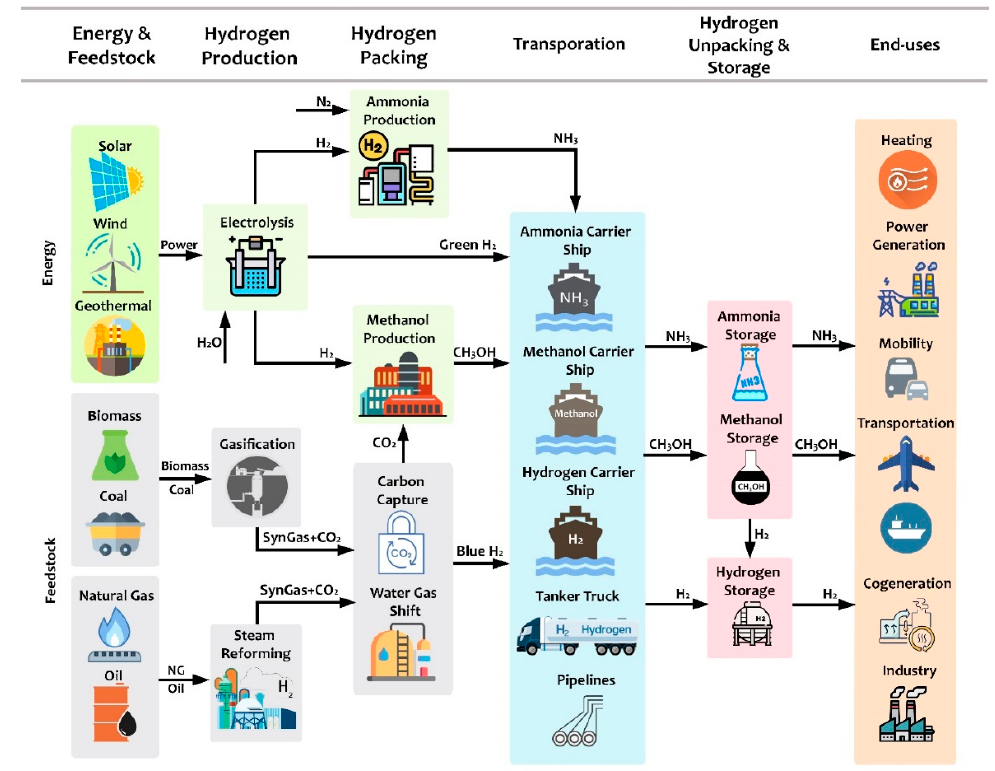
Figure 1. Value chain of clean hydrogen for the successful energy transition.